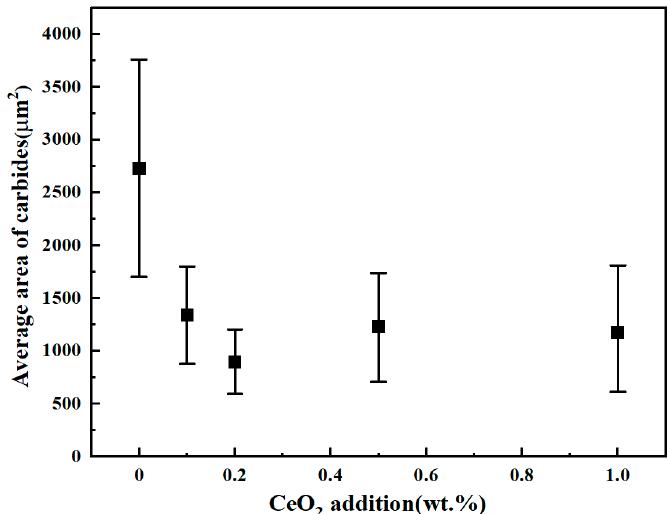
Figure 2. The average area of carbides in Ni-based tungsten carbide cladding layer under different CeO 2 addition.